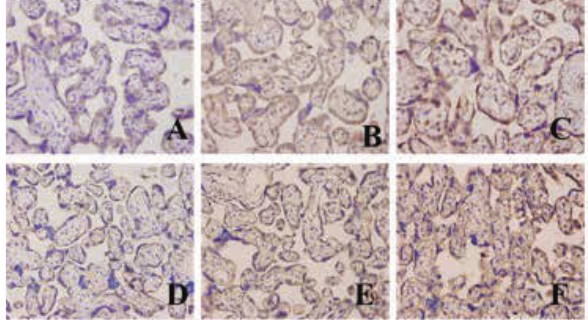
Figure 2: SREBP-1c mRNA expression in placentas of each group (A: severe PE, B: mild PE, C: normal)